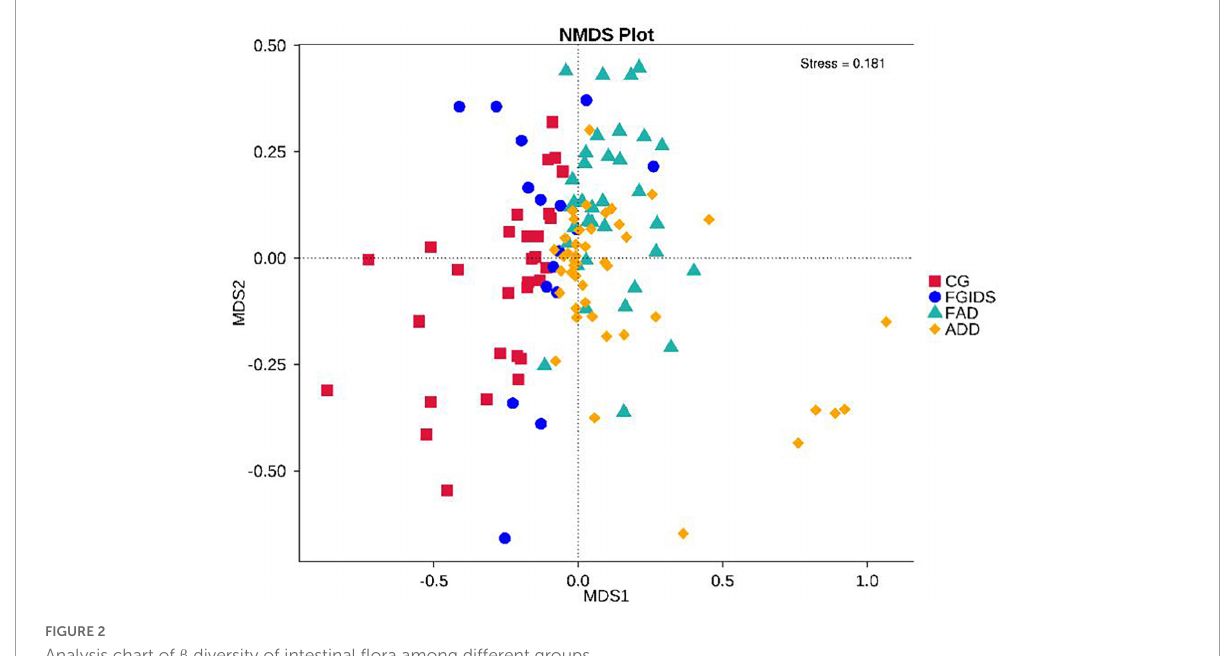
FIGURE2 Analysis chart of β diversity of intestinal flora among different groups.